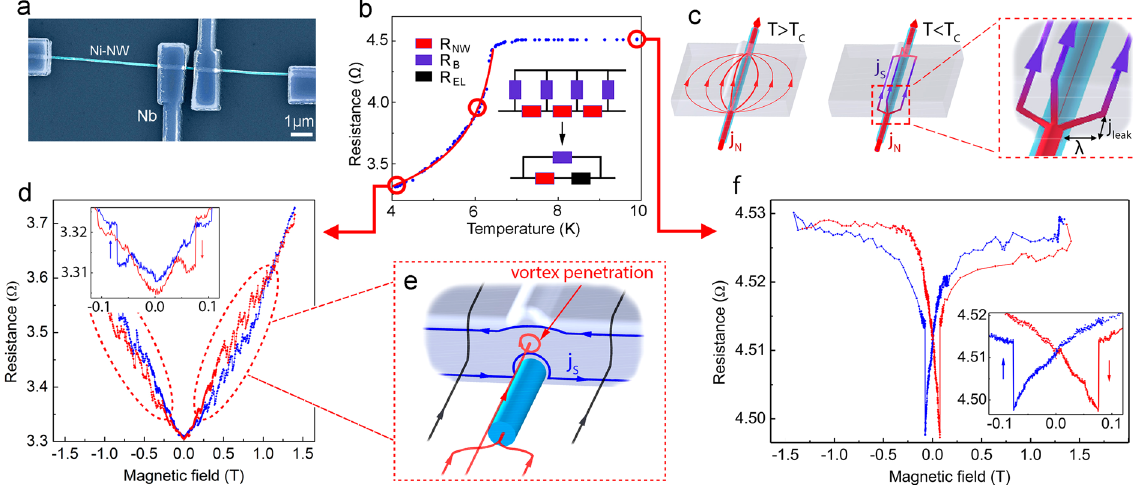
Figure 1. ( a ) Scanning Electron Microscopy image of the studied S/F-NW/S structure: Ni nanowire is coupled to four planar Nb electrodes. In the 4-probe measurements left and right electrodes serve for the current injection, and the two middle electrodes as voltage contacts. In the 2-probe experiments the middle electrodes are used as both voltage and current contacts. ( b ) Blue data points: R ( T ) dependence measured at I sam = 30 μ A with the 4-probe scheme. Red dashed line: a fit using the effective resistance model. Sketch: the effective resistance circuit of the of the Nb/Ni-NW interface (see in the text). ( c ) Sketches of the current distribution in the overlapping region between Ni-NW and Nb voltage electrodes in the 4-probe experiment (see Supplementary Materials). Left - in the normal state of the Nb layer; center - in the superconducting state; right: a zoomed sketch of the current distribution at the edge of Nb/Ni interface. The superconducting current lines are depicted in blue, the normal current lines are in red. ( d , f ) Magneto-resistance R ( H ) measured at T = 10 K and 4.2 K, respectively. Insets: hysteresis loops due to the Ni-NW magnetization switching at ± 0.076 T. Red dashed ellipses at ( d ) point to specific regions in R ( H ) where the Abrikosov vortex penetration causes a series of peaks in the magneto-resistance. ( e ) A sketch of the vortex penetration into Nb-electrodes at the Nb/Ni interface in the vicinity of the electrode’s edges (see in the